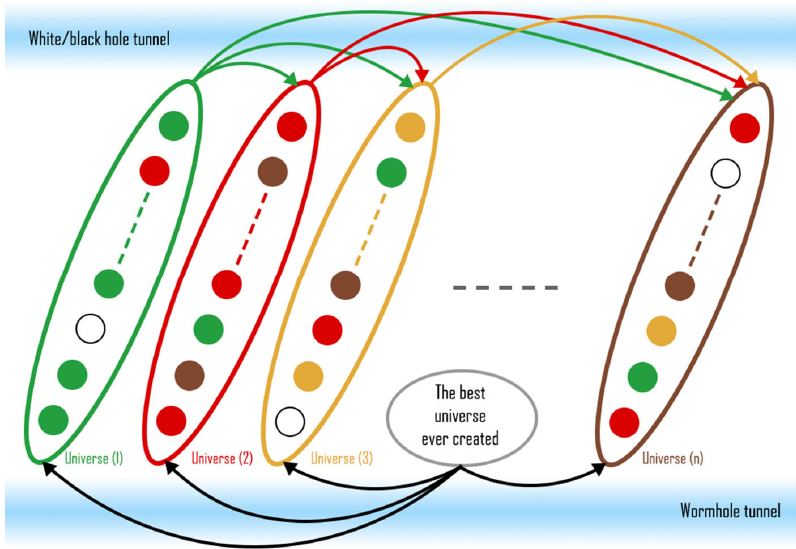
Fig. 1. Conceptual Model of MVO Algorithm (Mirjalili et al.,